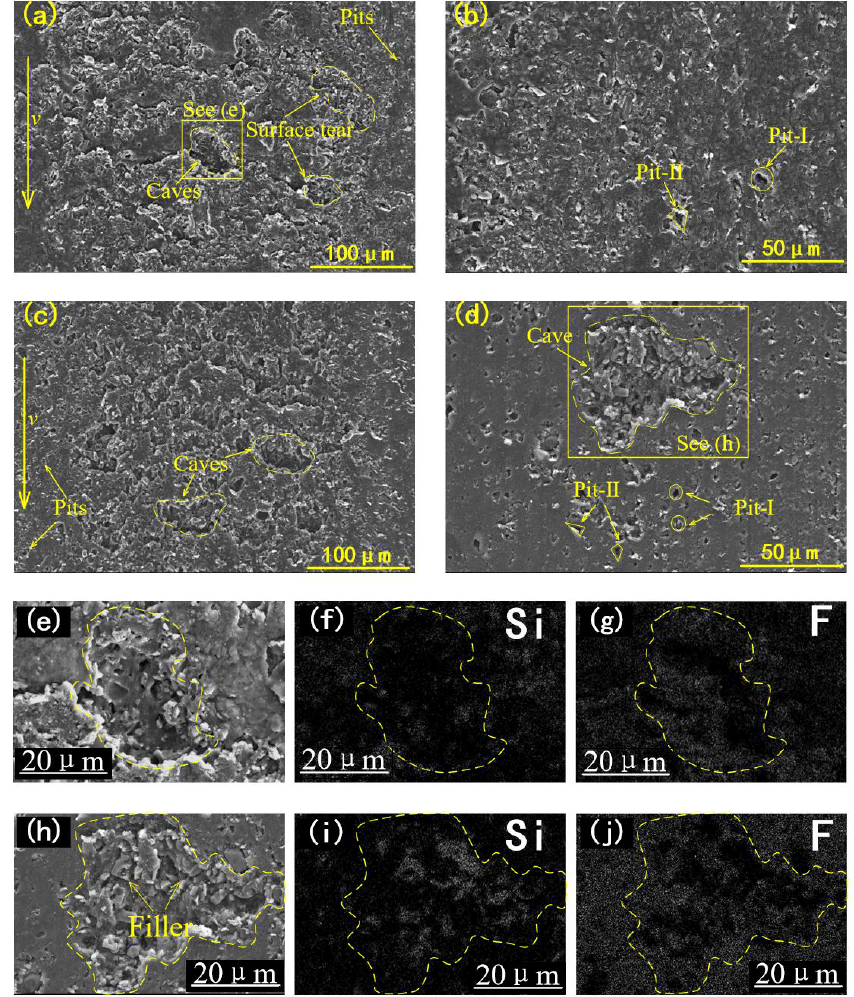
Figure 6. SEM micrograph of the worn surface of untreated specimens ( a ) in the center area and ( b ) in the edge area; the wear surface of treated specimens ( c ) in center area and ( d ) in edge area; ( e ) the cave in the center area of untreated spec- imens and its element mapping of ( f ) silicon and ( g ) fluorine; ( h ) the cave in the edge area of treated specimens and its element mapping of ( i ) silicon and ( j )